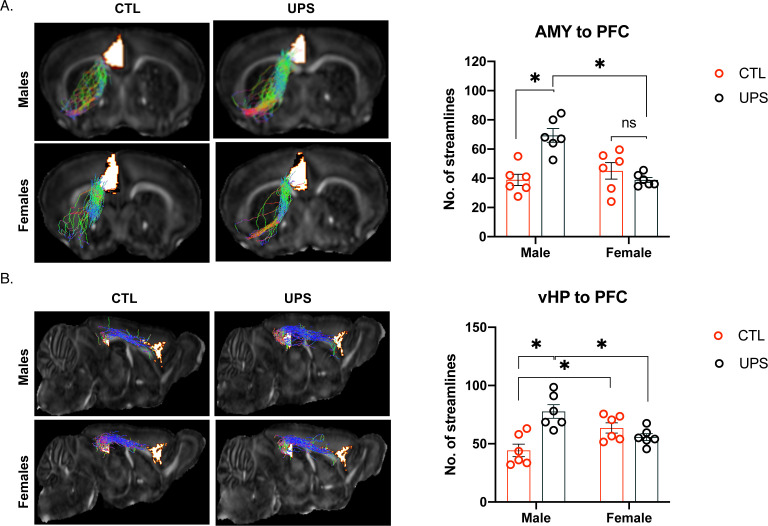
Unpredictable postnatal stress differentially alters PFC connections with the AMY and vHC in males and females.(A) Representative images and quantification of AMY–PFC tractography. (B) Representative images and quantification of vHC–PFC tractography. AMY – amygdala, PFC – prefrontal cortex, vHP – ventral hippocampus (n = 6 per rearing and sex group). Mean and SEM. *p<0.05.